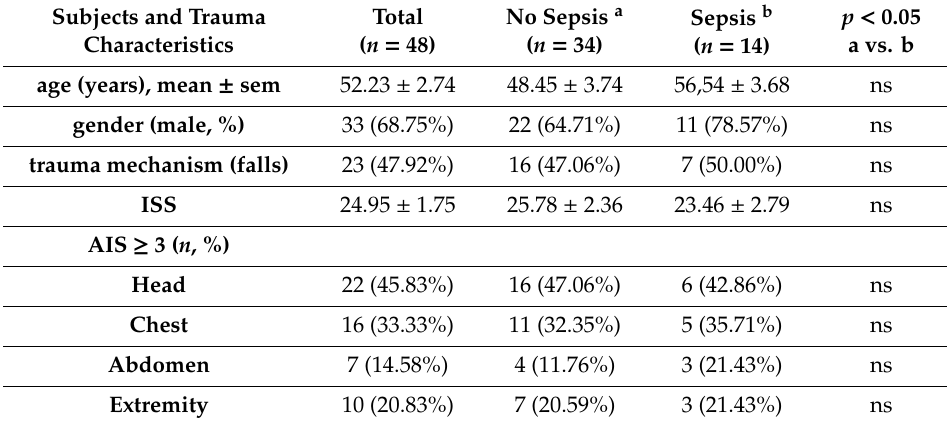
Table 1. Demographic and trauma characteristics of the study population. Data are given as mean ± standard error of the mean; p < 0.05. Abbreviations: a, no sepsis group; AIS, abbreviated injury scale; b, sepsis group; ISS, injury severity score; and ns, no